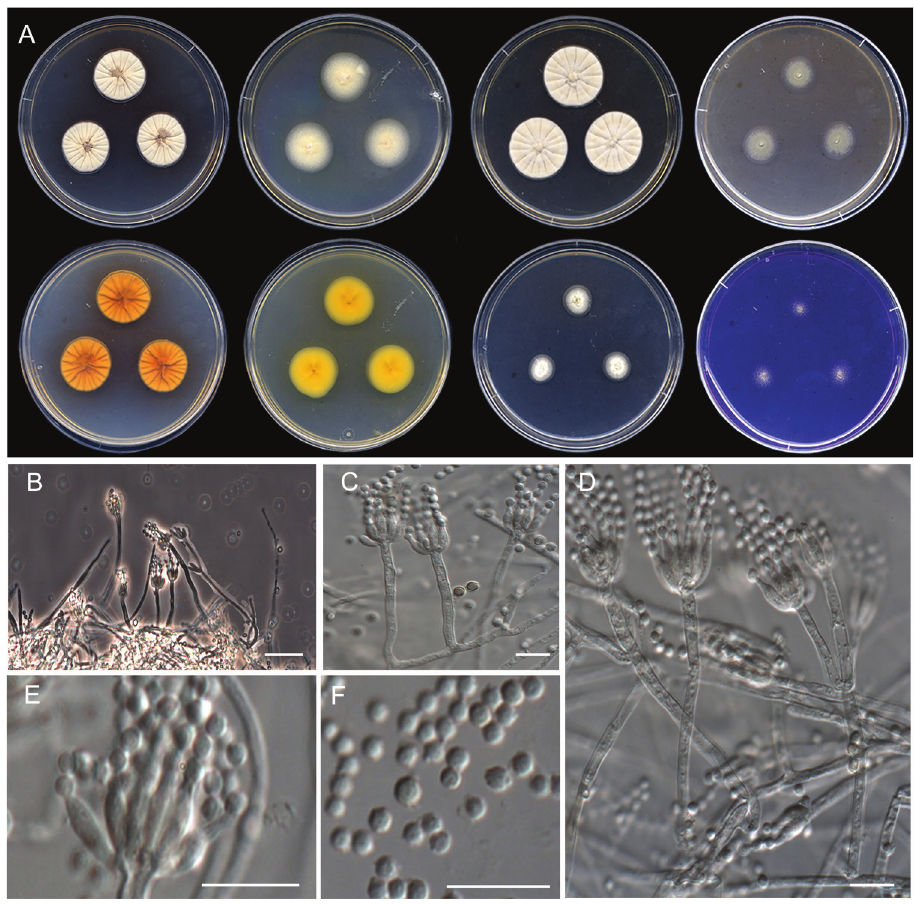
Figure 16. Morphological characters of Penicillium vaccaeorum (FMR 17967). A colonies from left to right (top row) CYA, MEA, YES, and OA; (bottom row) CYA reverse, MEA reverse, DG18, and CREA B–E conidiophores on MEA F conidia. Scale Bars: 25 μm ( B ), 10 μm ( C–F